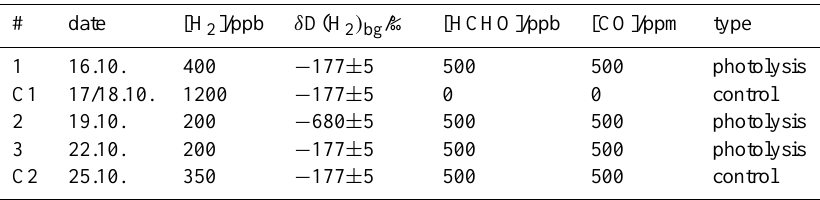
Table 1. List of gas mixtures used in the control and HCHO photolysis experiments.